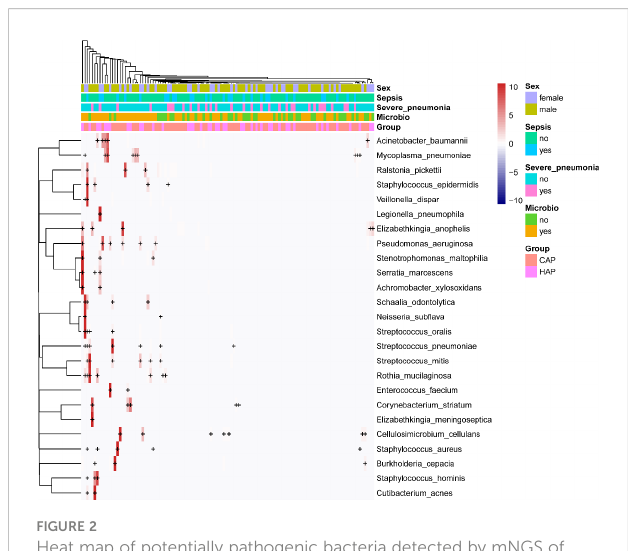
FIGURE 2 Heat map of potentially pathogenic bacteria detected by mNGS of BALF samples. For the top 25 bacteria, each horizontal row represents a sample, and each vertical column represents potentially pathogenic bacteria. The plus and minus signs in the graph represent signi fi cant positive and negative correlations, respectively. The clinical phenotype is at the top, and the color block on the right represents the value of the speci fi c clinical phenotype.